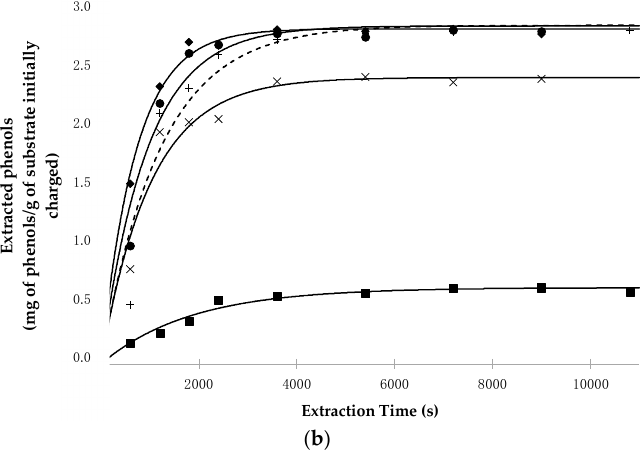
Figure 2. ( a ) Evolution of the experimental and calculated points related to the phenol extraction from lyophilized fruits of C. annuum L. as a function of extraction time and working conditions ( 50 °C, 30 MPa, Sc-CO 2 /EtOH (1:1, w / w ); 80 °C, 30 MPa, Sc-CO 2 /EtOH (1:1, w / w ); 80 °C, 30 MPa, EtOH 100%; 80 °C, 50 MPa, EtOH 100%; Soxhlet extraction, EtOH 100%); ( b ) Evolution of the experimental and calculated points related to phenol extraction from lyophilized peels of L. esculentum L. as a function of extraction time and working conditions ( 50 °C, 30 MPa, Sc-CO 2 /EtOH (1:1, w / w ); 80 °C, 30 MPa, Sc-CO 2 /EtOH (1:1, w / w ); 80 °C, 30 MPa, EtOH 100%; 80 °C, 50 MPa, EtOH 100%; + Soxhlet extraction, EtOH